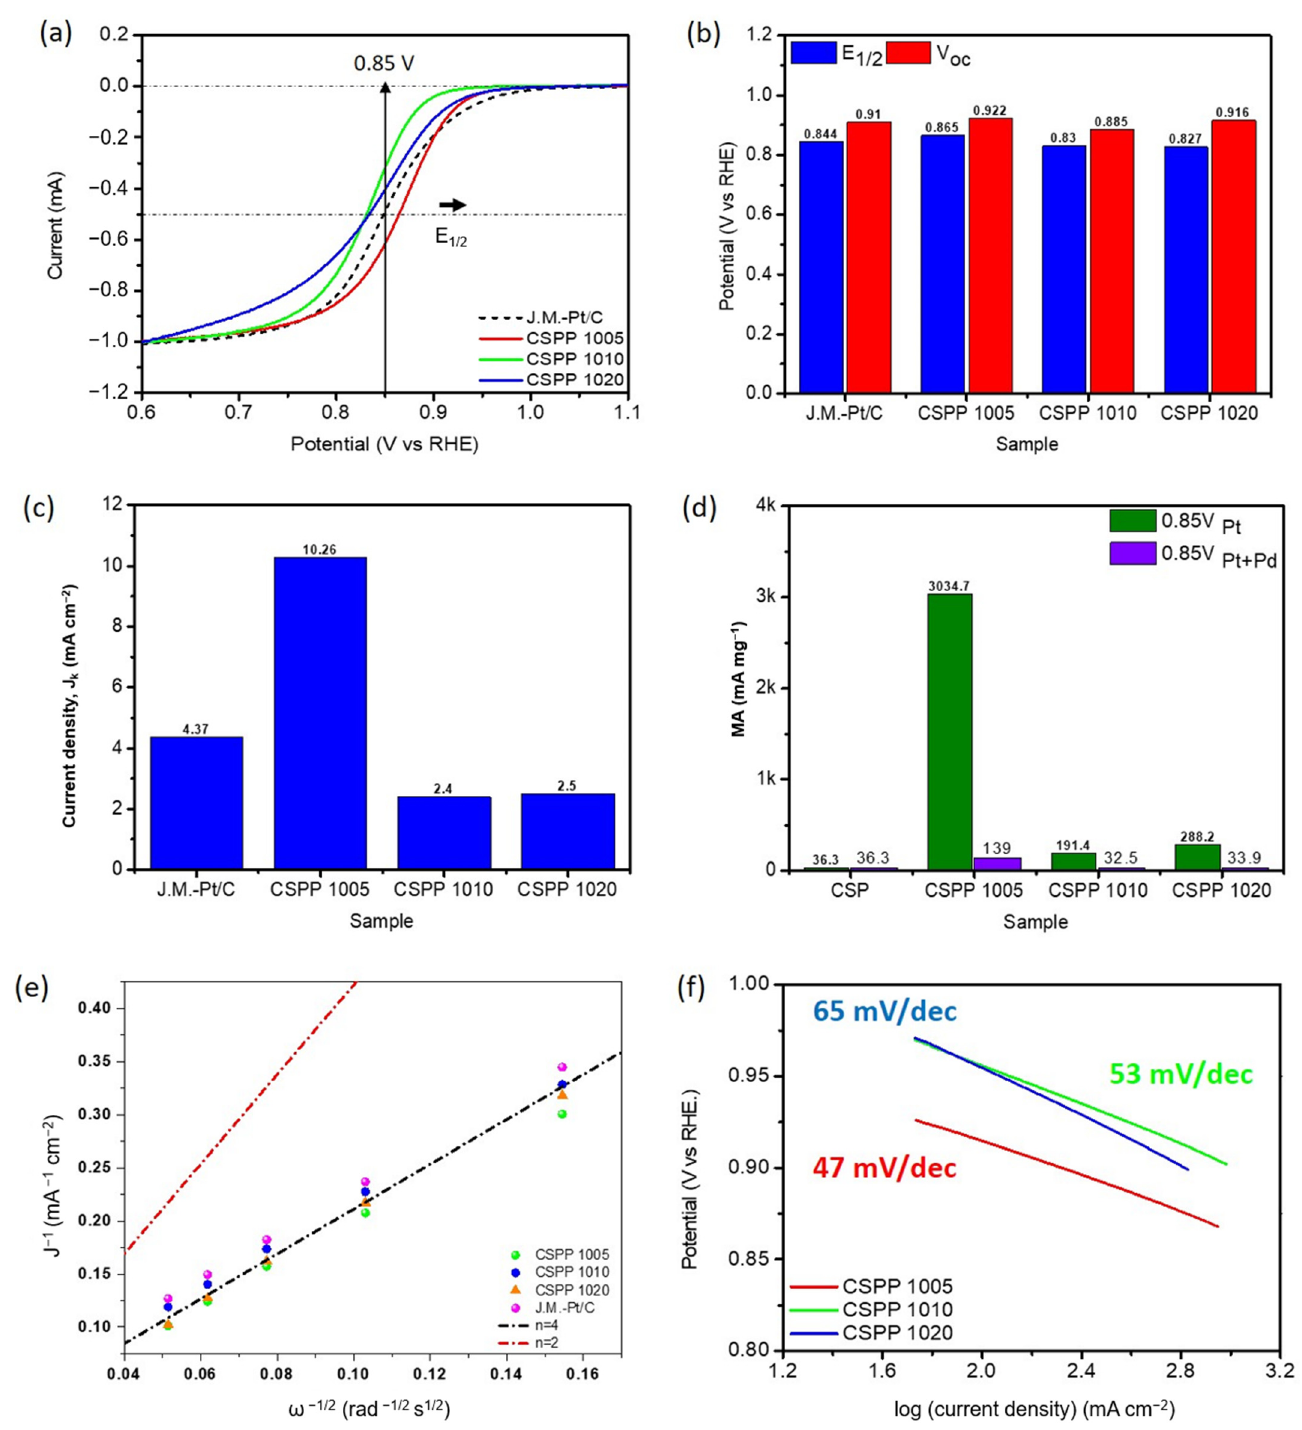
Figure 5. Electrochemical results of CSPP NCs. ( a ) LSV, ( b ) Onset potential (Voc)/half wave potential (E 1/2 ), ( c ) kinetic current density, and ( d ) ORR mass activity of CSPP NCs compared with the commercial J.M.-Pt/C NCs. ( e ) The Koutecky–Levich (K.L.) plots and ( f ) the Tafel slopes of CSPP NCs.